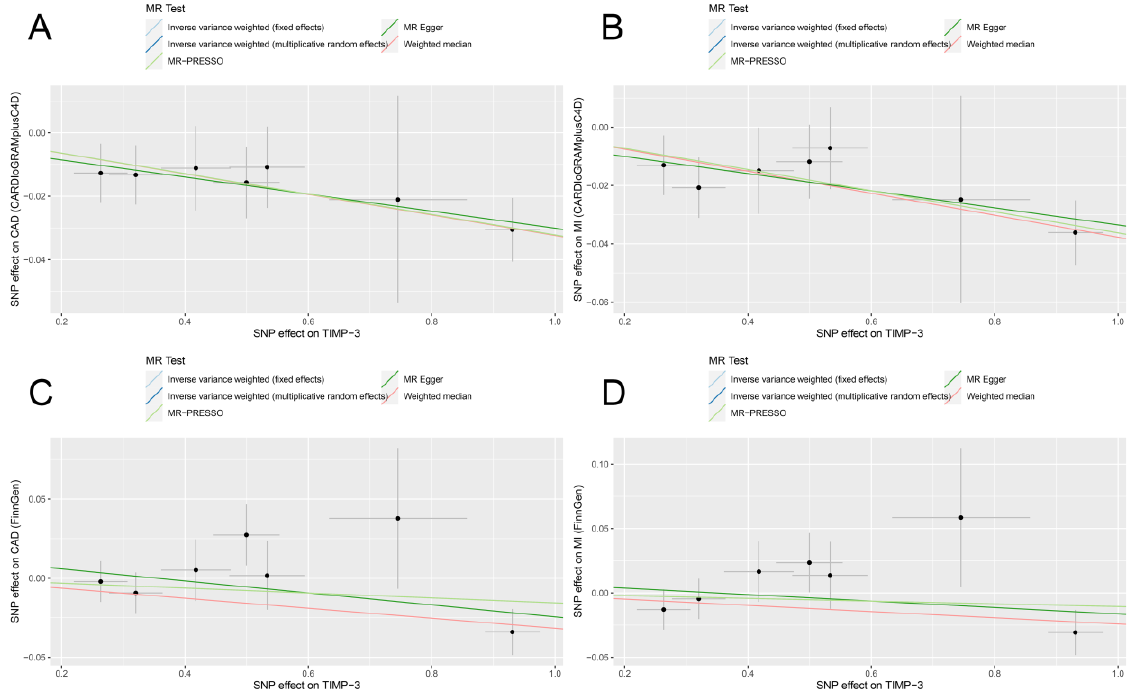
Figure 3. Scatter plot of the MR estimates for the association of serum TIMP3 levels with risk of CAD and MI based on CARDIoGRAMplusC4D ( A , B ) and FinnGen ( C , D ). TIMP3, tissue inhibitors of matrix metalloproteinase 3; CAD, coronary artery disease; MI, myocardial infarction; CARDIo- GRAMplusC4D, Coronary Artery Disease Genome − Wide Replication and Meta − Analysis plus the Coronary Artery Disease Genetics; MR − PRESSO, MR Pleiotropy Residual Sum and Outlier. Dots refer to SNPs. Table 2. Association of genetically predicted circulating TIMP3 levels with CAD and MI risk in complementary analyses.